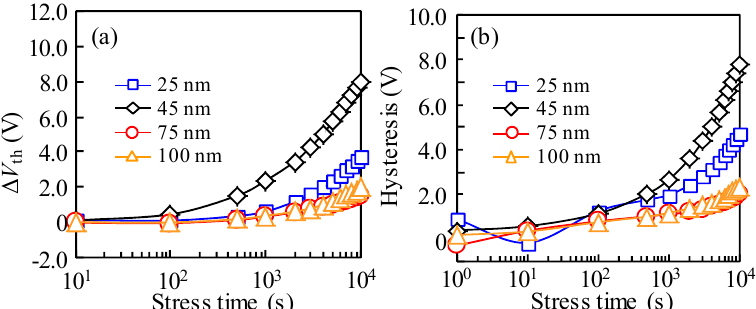
Figure 4. ( a ) The V th variation in the reverse scan and ( b ) hysteresis change as a function of stress duration.